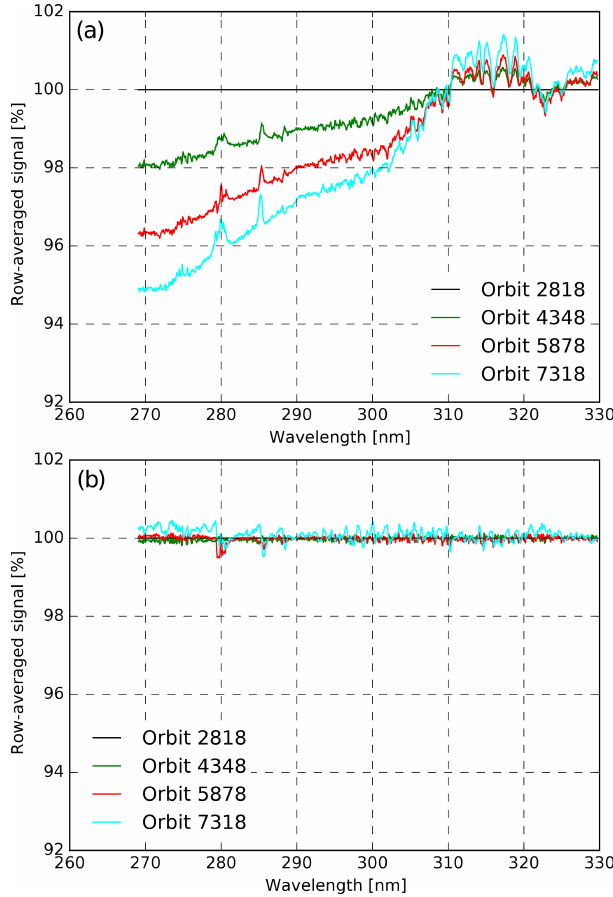
Figure 14. Row-averaged irradiance signal of the UVIS detector via QVD1 for orbits 2818 (flat black line), 4348 (green), 5878 (red) and 7318 (cyan). The plot (a) is without degradation correction and clearly shows the spectral dependence of the degradation but no increase in signal unlike the UV detector in Fig. 13. The plot (b) shows the corrected signal where the degradation CKD used only the measurements up to and including orbit 5878. The latest orbit in the plot (cyan) is corrected using extrapolation in the L1b